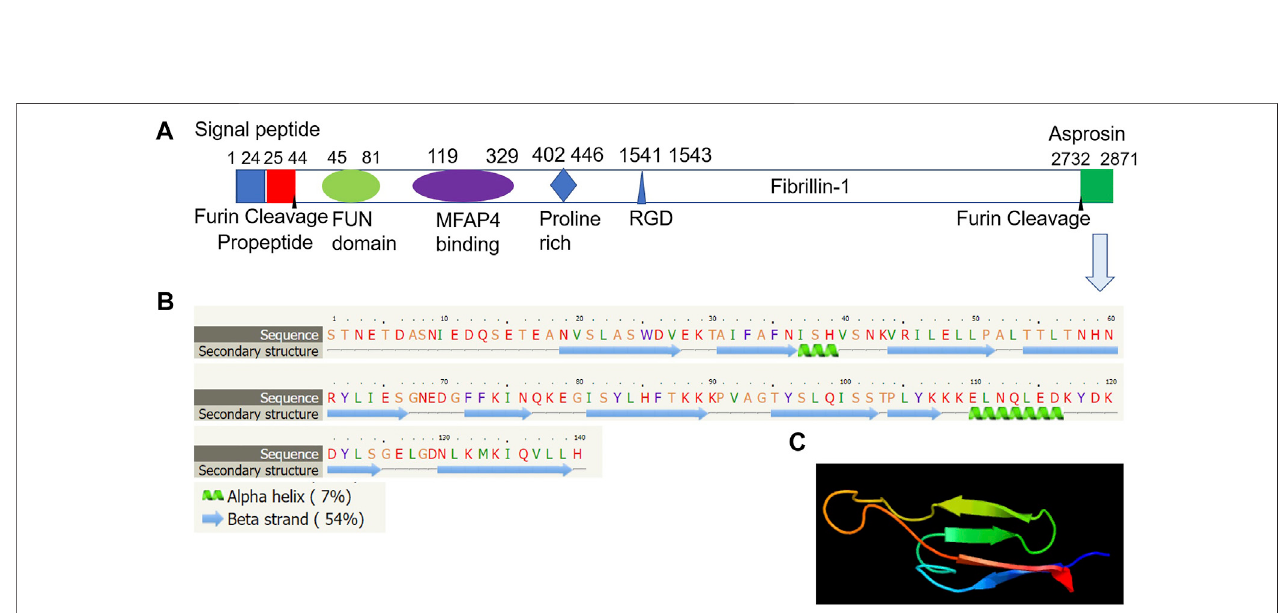
FIGURE2| Molecularstructureofhumanasprosinprotein. (A) Asprosin(aa2732-2871)isderivedfromtheC-terminalregionofpre fi brillin-1whichcontainsasignal peptide (aa1-24), propeptide (aa25-44), a furin cleavage motif after RAKR (aa44), fi brillin unique N-terminal (FUN) domain (aa45-81), micro fi brillar-associated protein 4 (MFAP4) interacting domain (aa119-329), proline rich domain (aa402-446), RGD motif (aa1541-1543), a furin cleavage motif after RKRR (aa2731), and fribrillin-1 (aa25- 2731). (B) Asprosin ispredictedtoconsist oftwoalpha helixes and several betastrandsbased on theanalysis byPhyre2web portal (http://www.sbg.bio.ic.ac.uk/ phyre2/). (C) Tertiarystructureanalysisshowinghumanasprosinproteinthatmimicscrystalstructureofcadherin8ec1domainbasedontemplatec1zxkB,whichhas46 residues (33% of asprosin sequence) have been modelled with 95.2% con fi dence by the single highest scoring template using Phyre2 web portal analysis (http://www. sbg.bio.ic.ac.uk/phyre2/).